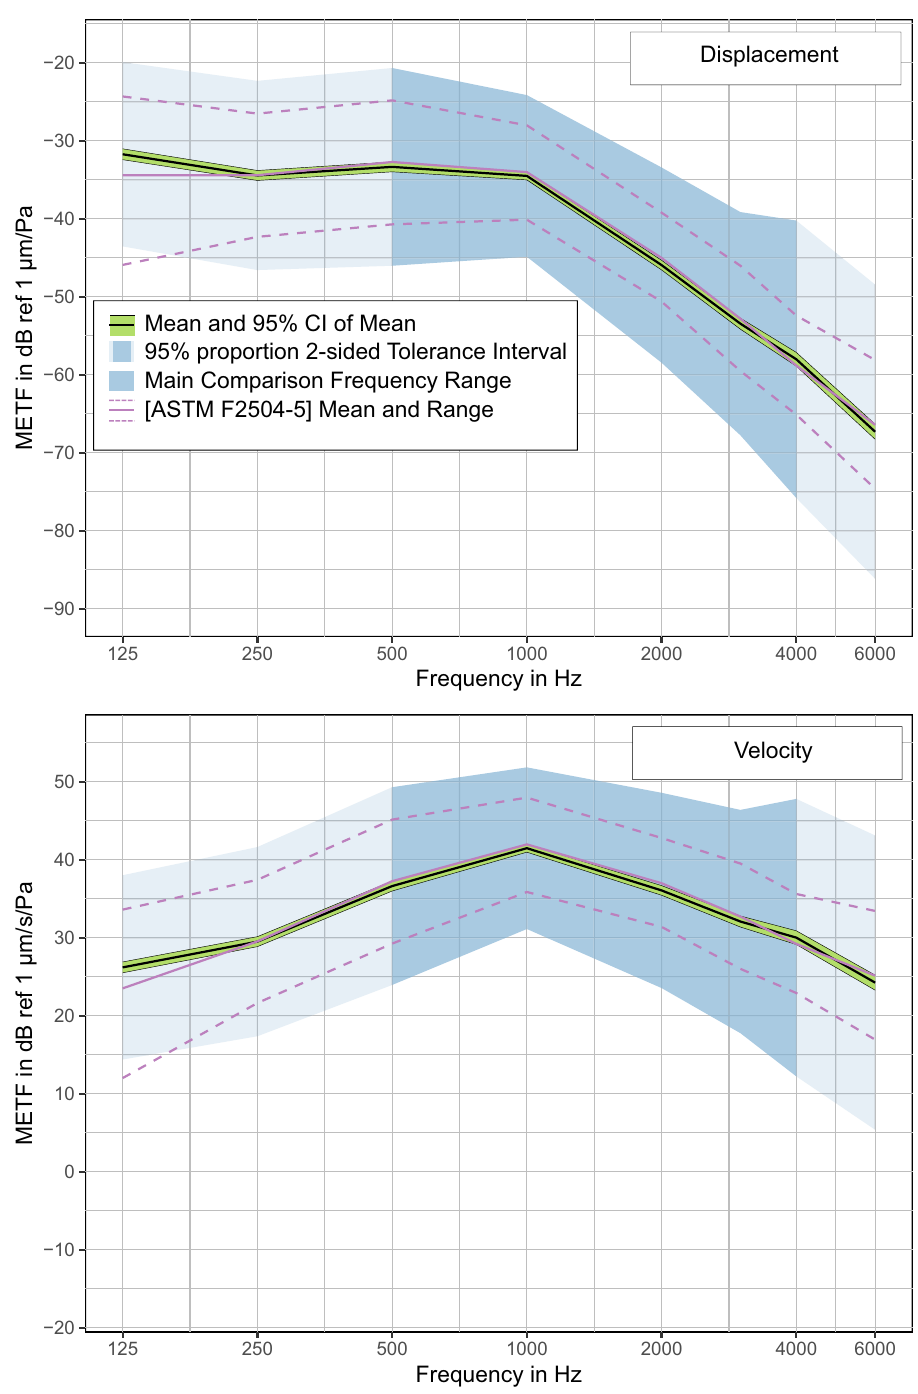
Figure 6. Proposed reference for METF measurements. The reference range is calculated as the 2-sided 95% tolerance interval. Upper: stapes footplate displacement in dB ref µm/Pa. Lower: stapes footplate velocity in dB ref µm/s/Pa. Inferential statistics from 366 METF measurements based on measurement method "A" (single point LDV on stapes footplate) from 4 research groups (Dresden, Hannover, Shanghai, Zürich). Literature (ASTM) range is included as